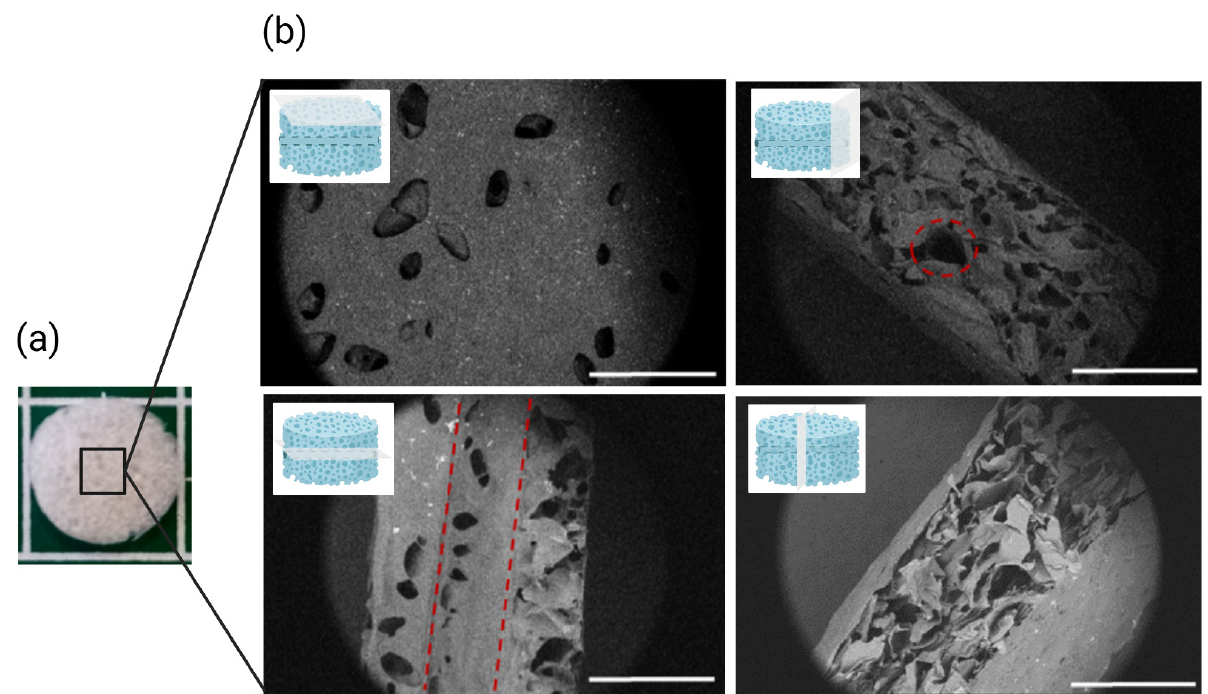
Figure 2. ( a ) Image of the hydrogel showing pores visible to the naked eyes. Scale bar = 5 mm; ( b ) SEM images of the surface, the edges and the cross-section of the hydrogel with a preformed channel. Red dash circle shows the circular cross-section of the microchannel (ø~100 µ m), observed on the side of the hydrogel. Red dashed lines represent the limit between the hollow channel and the hydrogel surface. Scale bar = 1 mm.